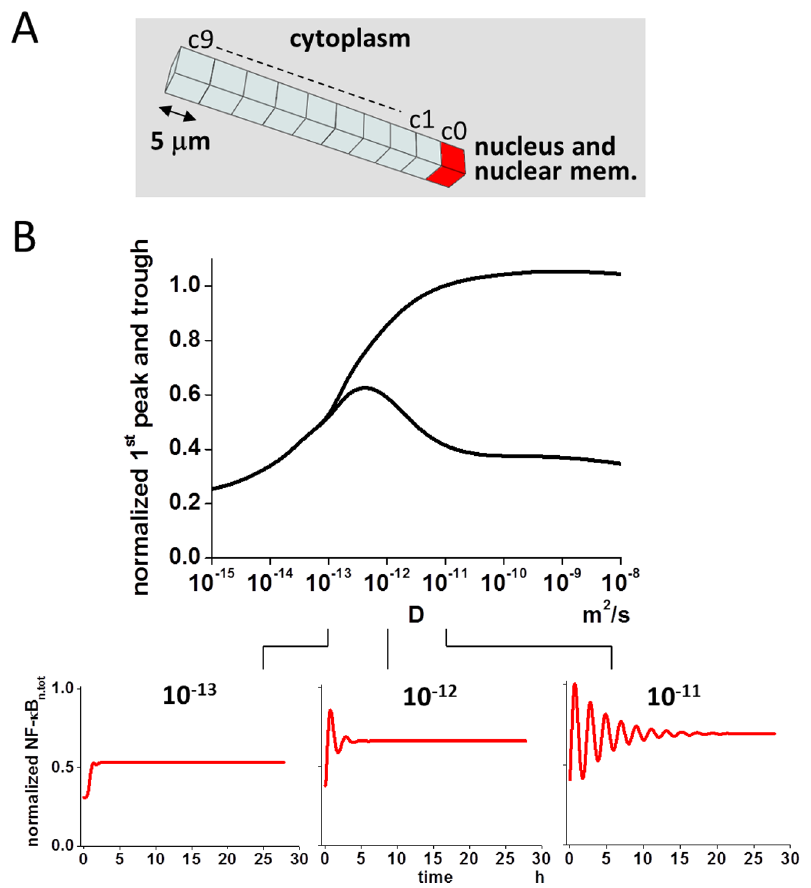
Figure 2. Bifurcation-like regulation of nuclear NF- k B oscillation by diffusion coefficient. (A) To investigate the effect of a diffusion coefficient on the oscillation of NF- k B n.tot , a simple 1D model was constructed. There were 10 cubic compartments (c0, c1,---,c9), measuring 5 m m along each side, and the rightmost compartment was assigned as the nucleus and nuclear membrane (red cube). (B) Oscillation was investigated with a wide range of diffusion coefficient of proteins from 10 2 15 to 10 2 8 m 2 /s. By plotting the concentration of NF- k B n.tot at the first peak and trough, a bifurcation-like diagram was clearly seen. At D lower than 10 2 12 m 2 /s, oscillation was not observed, while at D higher than this, oscillation was observed, becoming more pronounced at higher